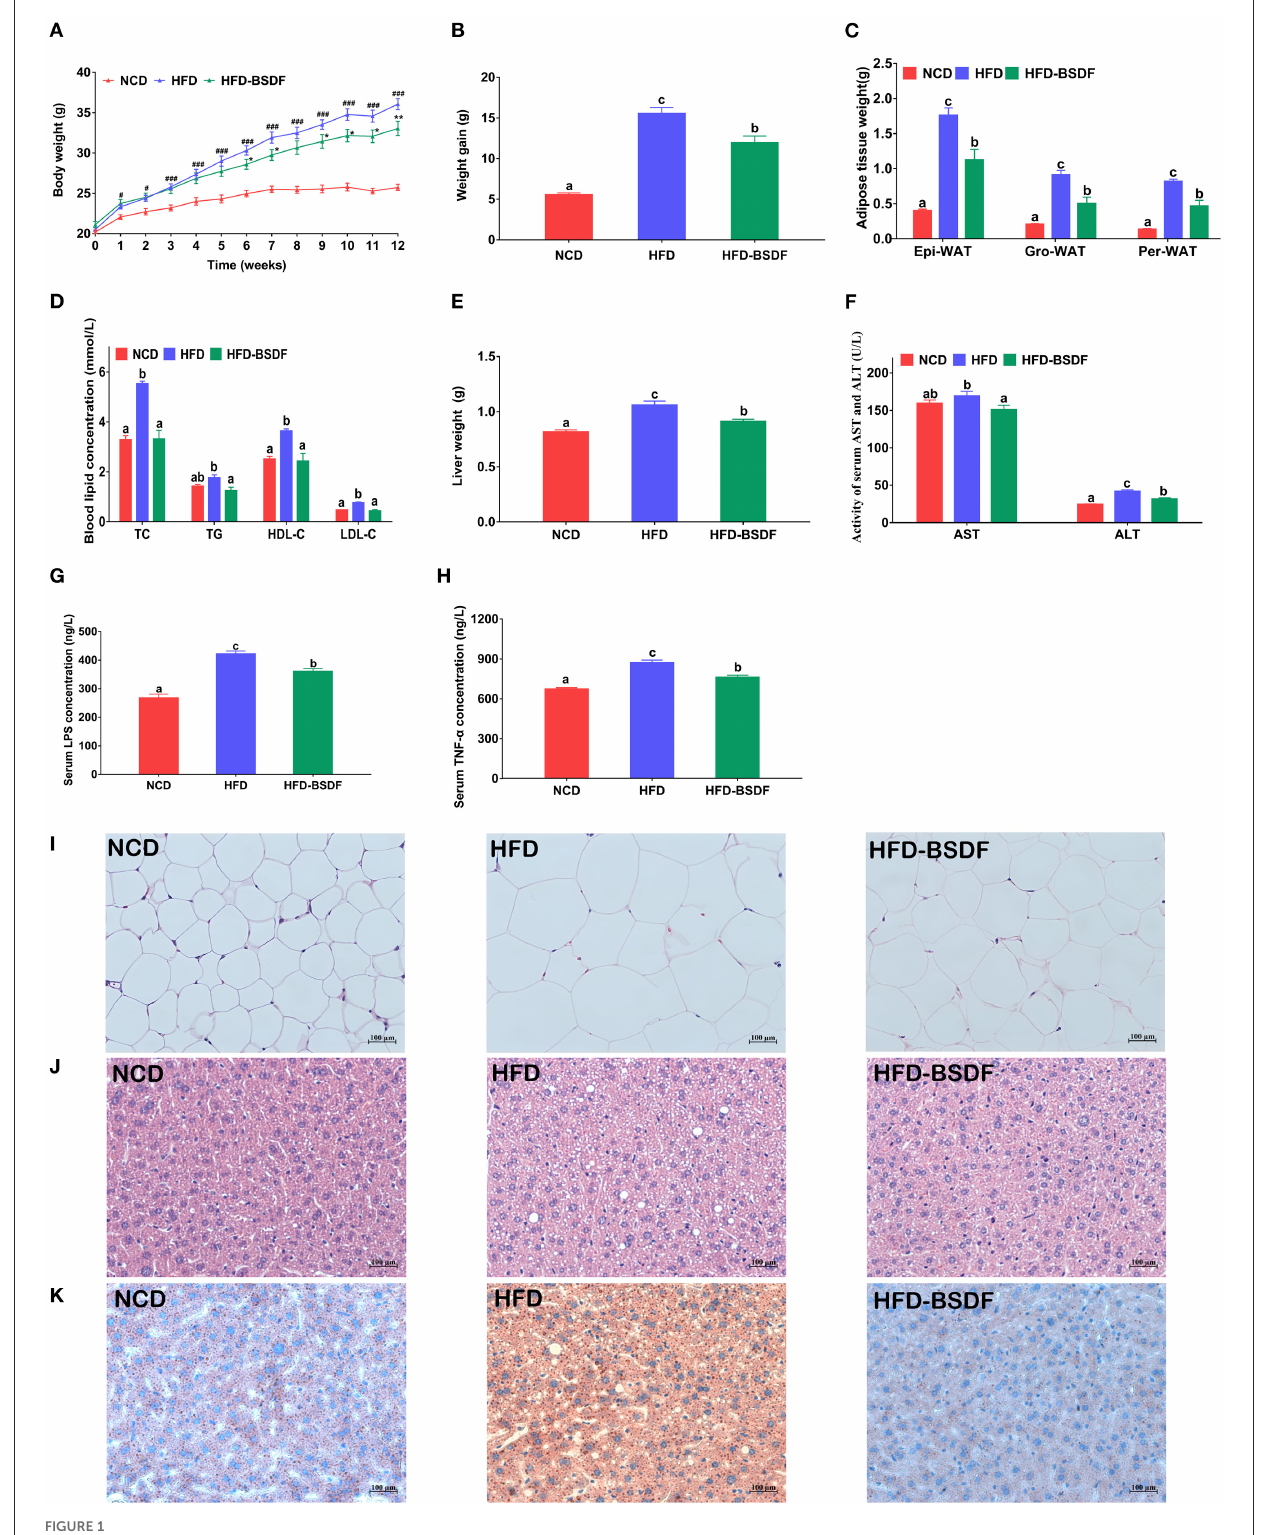
FIGURE1 BSDF alleviation of HFD-induced obesity. (A) Body weight vs. time profiles; (B) weight gain; (C) white fat weight; (D) serum lipid level; (E) liver weight; (F) serum ALT and AST concentrations; (G) serum LPS concentration; (H) serum TNF- α concentration; (I) H&E staining of epididymal fat sections; (J) H&E staining of liver tissue; (K) Oil Red O staining of liver. Data presented as mean ± SEM, n = 8 per group. # p < 0.05, ### p < 0.001, HFD vs. NCD; * p < 0.05, ** p < 0.01, HFD–BSDF vs. HFD. a, b, c means in the same bar without a common letter differ at p < 0.05. Epi-WAT, epididymal fat; Per-WAT, perirenal fat; Gro-WAT, groin fat. NCD, normal control diet; HFD, high-fat diet; HFD-BSDF, high-fat diet supplemented with 6% BSDF freeze-dried